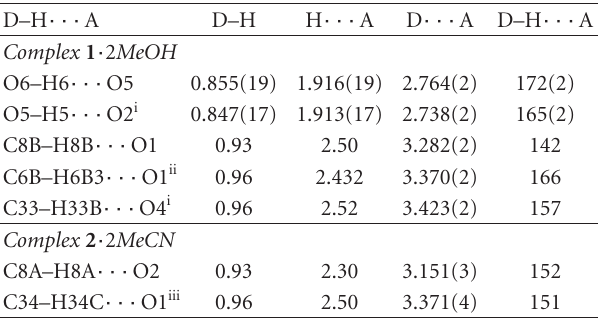
Table 4: Hydrogen-bond geometries for 1 · 2MeOH and 2 · 2MeCN ( ˚A, ◦